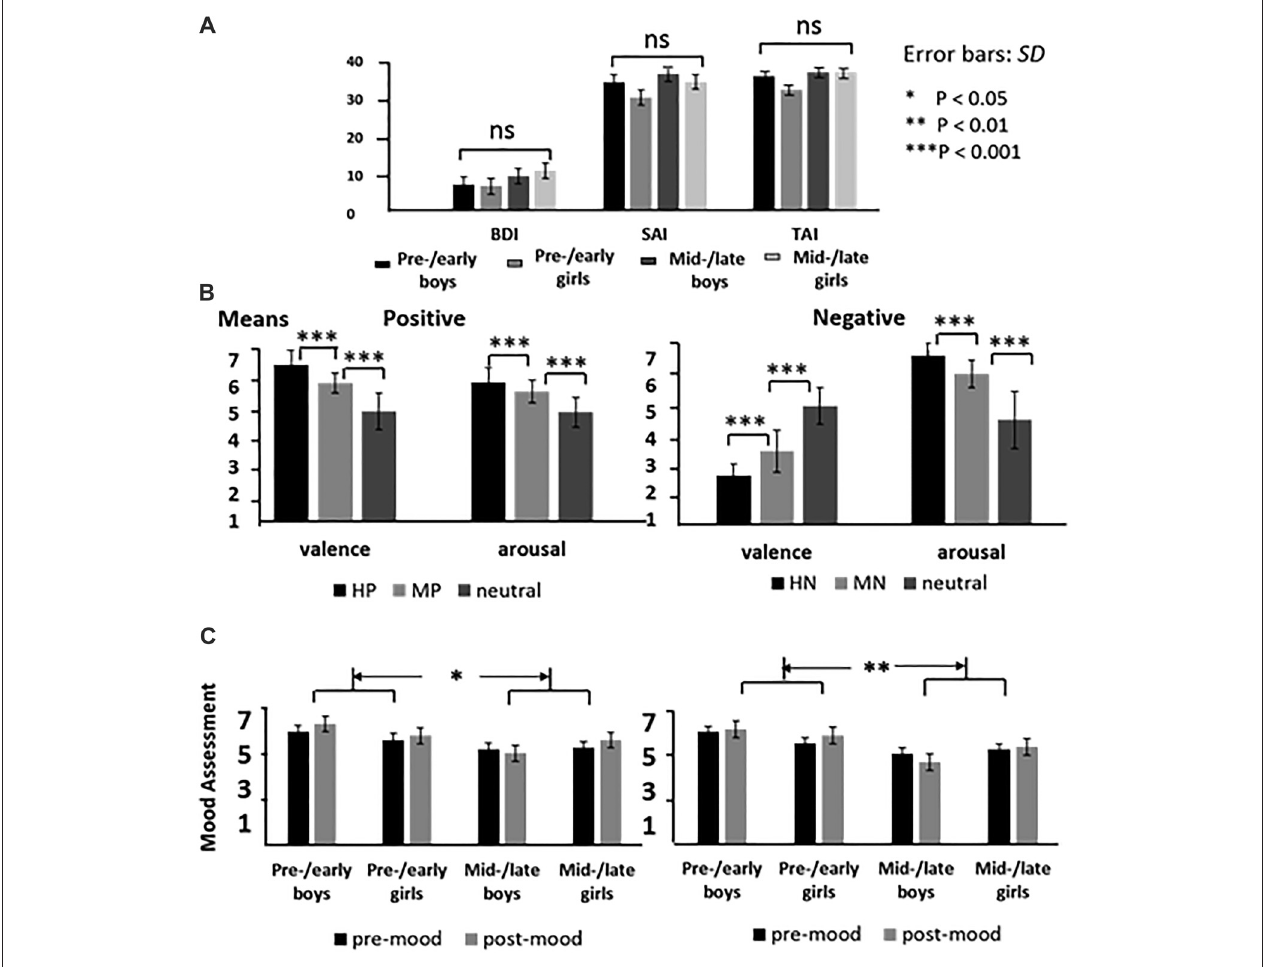
FIGURE 1 | The means of emotional inventory scores for each group (A) ; the means of valence and arousal for highly emotional, mildly emotional and neutral picture sets in positive and negative blocks (B) , and the means of the mood assessment for each group before and after the experiments (C)